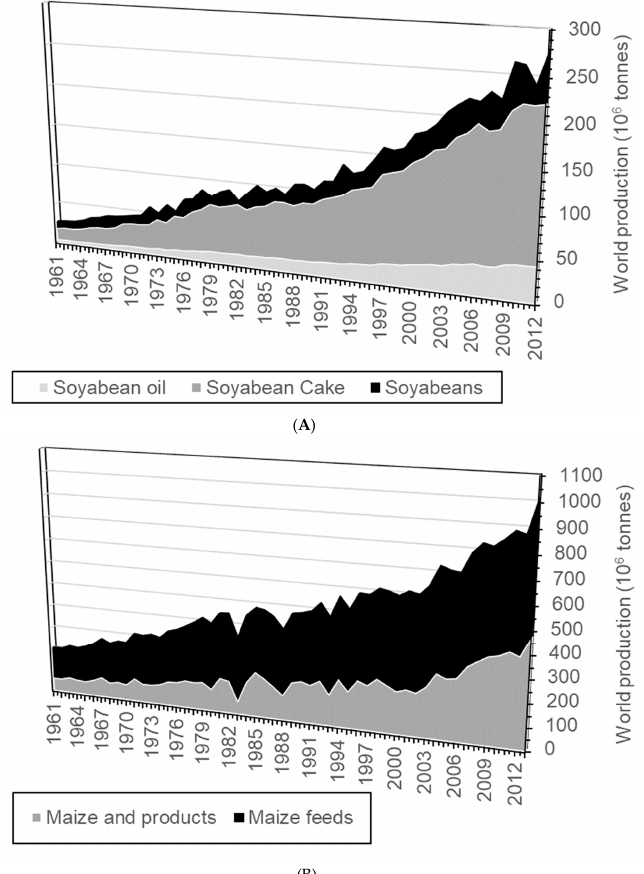
Figure 1. ( A ) The global production of soybean products and their use as feed 1961–2012 [7]. ( B ) The global production of maize products and their use as feed 1961–2012 [7] .